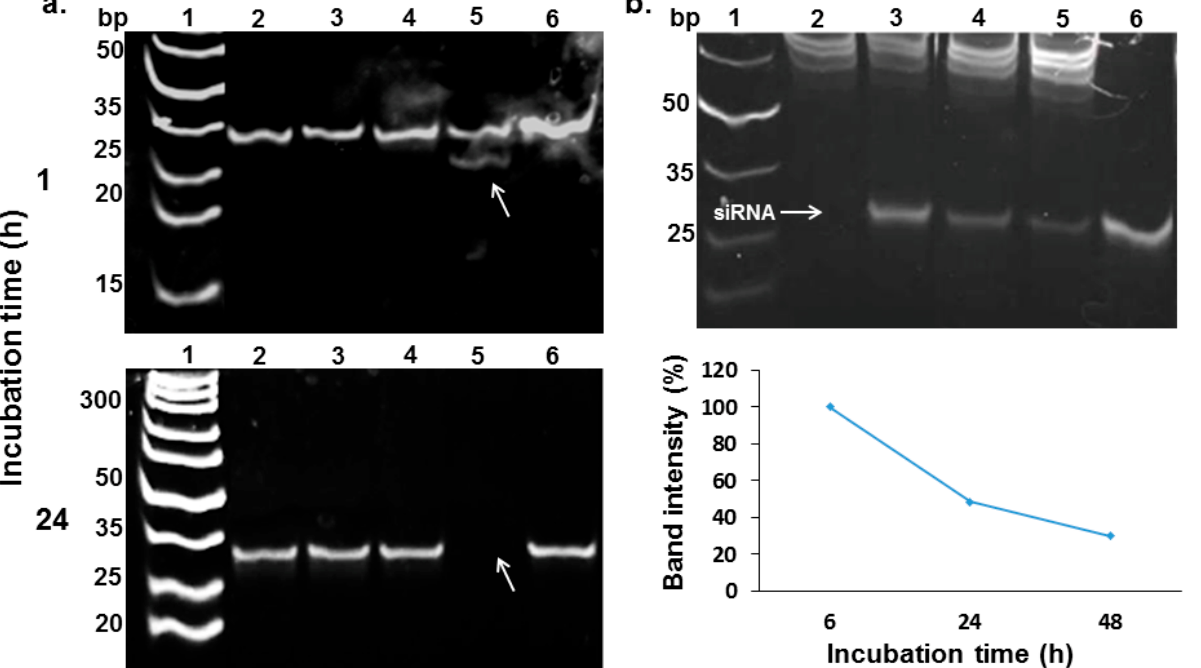
Figure 4. Evaluation of encapsulated siHSV stability in simulated physiological conditions. ( a ) The integrity of siHSV extracted from Lip-siHSV following incubation in 50% bovine serum albumin at 37 °C for 1 and 24 h: (1) Ladder; (2) extracted siHSV incubated in TE buffer; (3) extracted siHSV incubated in serum; (4) free siHSV incubated in TE buffer; (5) free siHSV incubated in serum; and (6) free siHSV without incubation. An aliquot of each sample (200 nM) was analyzed by native 24% acrylamide gel, stained with SYBER Gold. ( b ) The integrity of encapsulated siHSV in comparison to a spiked sample of empty liposomes with siHSV (200 nM) in keratinocytes (HaCaT) cell cultures: (1) ladder; (2) empty liposomes spiked with siHSV after 6 h; (3) Lip-siHSV after 6 h; (4) Lip-siHSV after 24 h; (5) Lip-siHSV after 48 h; and (6) free siHSV with no incubation. The semi-quantification (ImageJ analysis) of siHSV bands intensities is shown at the lower right-hand part of b. An aliquot from each sample of extracted RNA was analyzed (200 nM) by native 24% acrylamide gel, stained with eth- idium bromide, and visualized. Free siHSV with no incubation (lane 6) was set as 100% recovery.